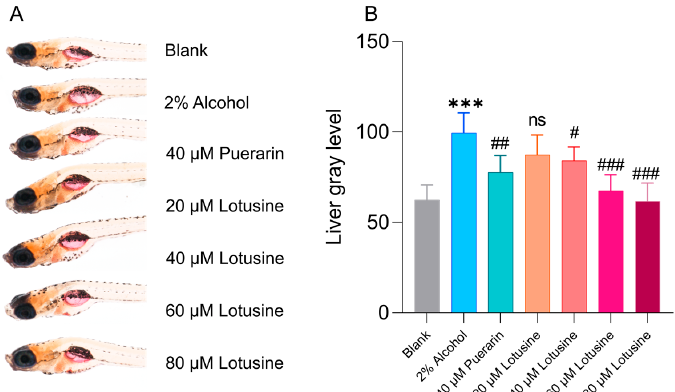
Figure 10. Alleviating effects of lotusine on hepatic steatosis induced by alcohol. ( A ) Photos of Oil Red O staining. ( B ) Quantitative analysis of results of Oil Red O staining. *** p < 0.001 vs. blank; ### p < 0.001 vs. alcohol exposure group; ## p < 0.01 vs. alcohol expose control; # p < 0.1 vs. alcohol expose control; ns, not significant; n = 7.